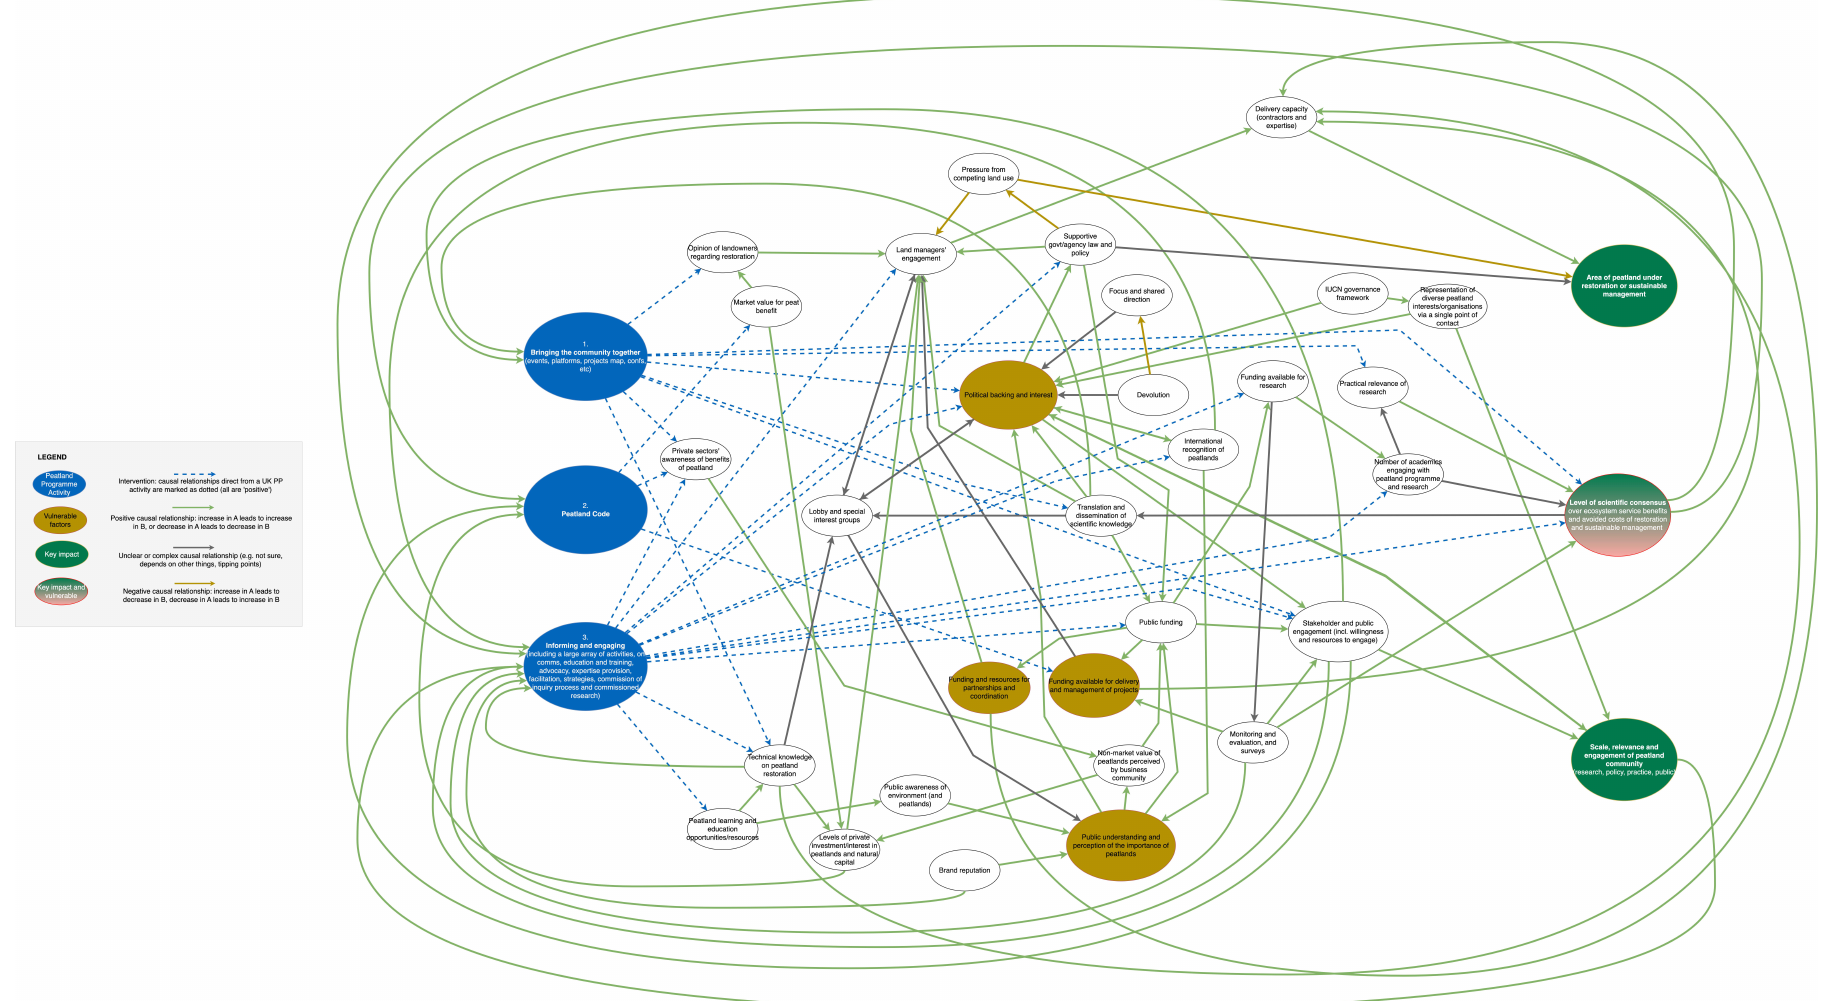
Figure 2. The full Participatory System Map of the UK peatland management